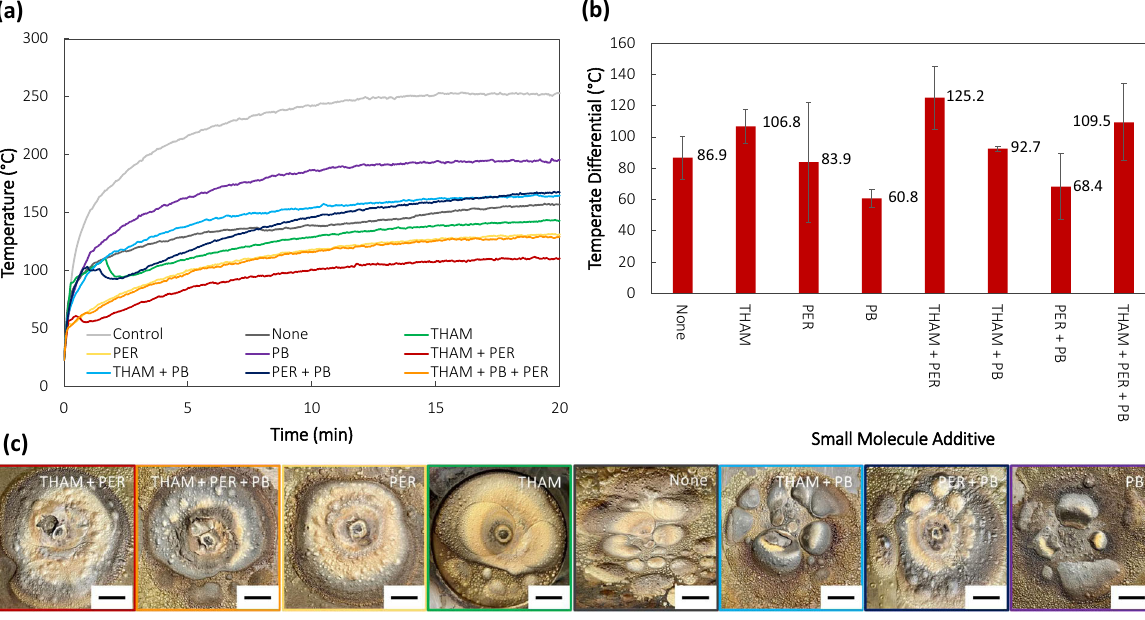
Fig. 4 Flame testing results. a Temperature curves during torch testing of 14 BL fi lms on steel, b the resultant temperature differential when compared to the uncoated control substrate ( Δ T fi lm = Tmax,control − Tmax, fi lm), and c the morphology of each of the samples following the torch testing, shown in order from best performing to worst. Error bars are standard deviation and scale bars are 1